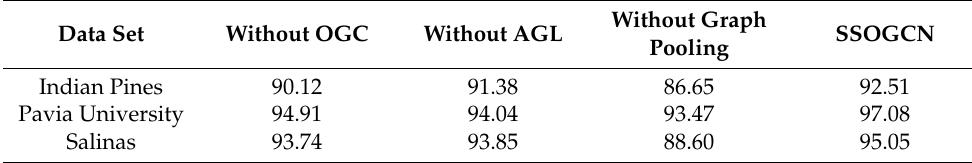
Table 8. Ablation study (%).